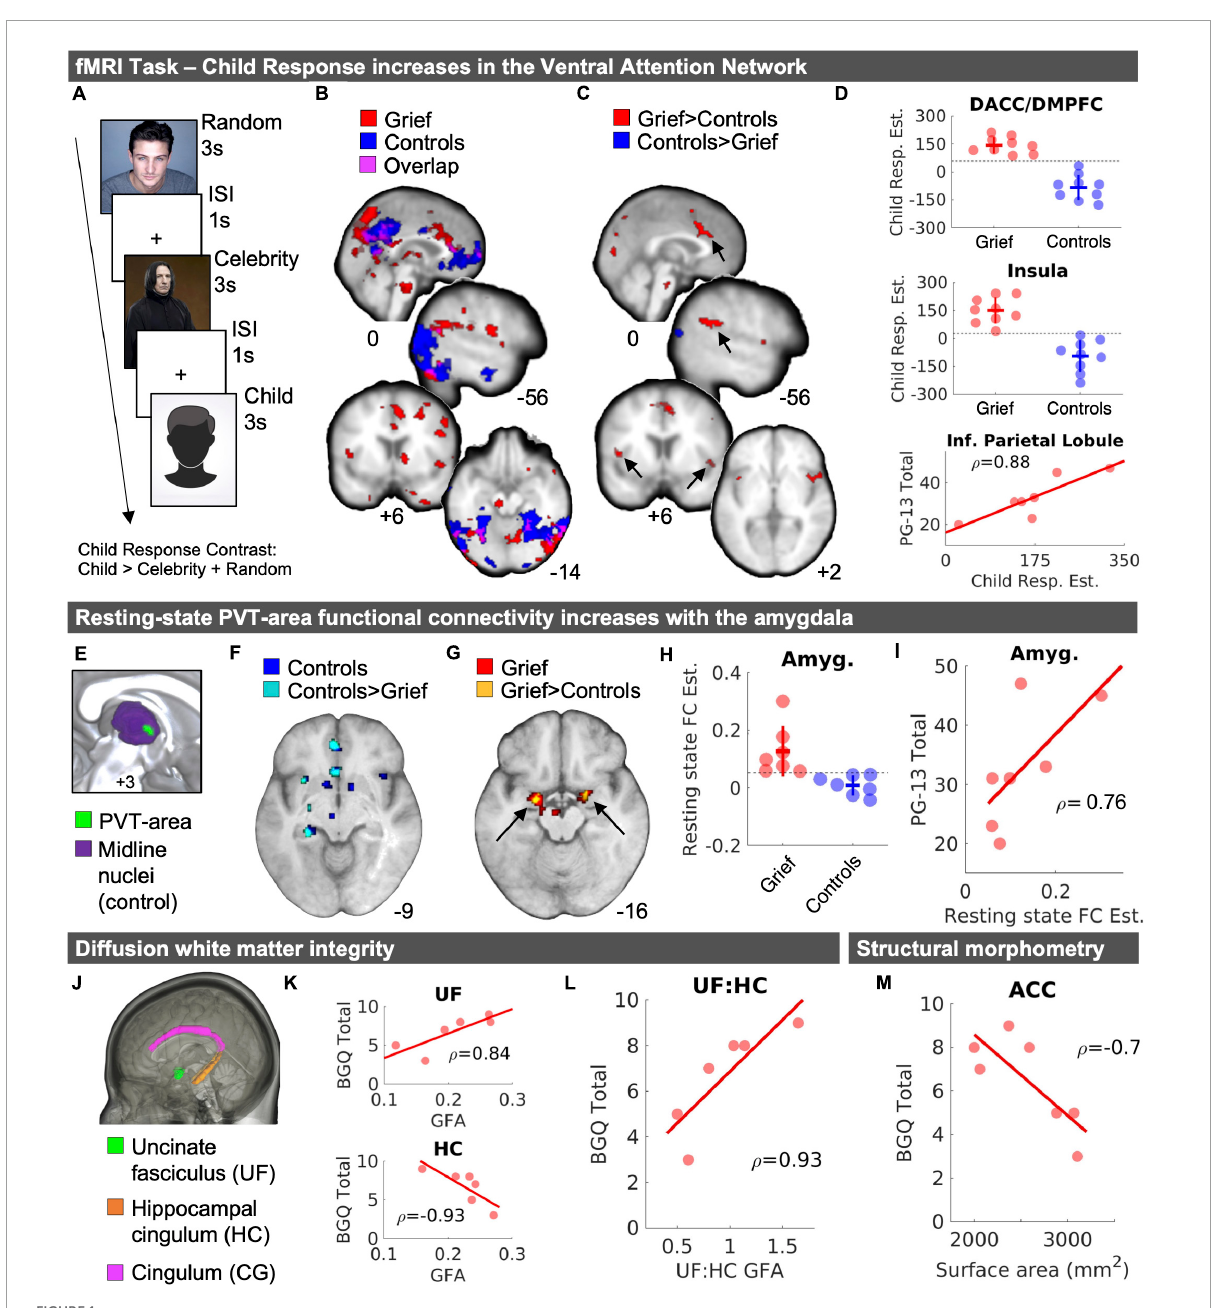
FIGURE1 MRI results. (A) Task structure. (B) Child fMRI Response (Child > Celebrity + Random) for Grief (red) and Control (blue) mothers and the spatial overlap of voxels shared between groups (violet). (C) Independent samples t- test results demarcate greater Child fMRI Responses in Grief compared to Controls (red) and Controls compared to Grief (blue). Arrows point to regions with corresponding plots in panel (D) . (D) Individual data points of Child fMRI Response magnitude in the dACC/DMPFC (top) and insula (middle) shown with standard deviation crossbars and dotted line illustrates numerical split between groups. The bottom panel of part (D) depicts a correlation between Child fMRI Response magnitude and subjective grief on the PG-13 in the inferior parietal lobule. (E) Midline view of PVT-area resting state functional connectivity analysis seed regions. (F) Resting-state fMRI results of PVT-area functional connectivity in controls (blue) and voxels that showed greater connectivity in controls compared to Grief mothers (cyan). (G) Resting-state fMRI results of PVT-area functional connectivity in Grief mothers (red) and voxels in the amygdala that showed greater connectivity in Grief mothers compared to controls (yellow). (H) Individual datapoints of PVT-area functional connectivity by group. The horizontal line highlights the complete numerical split between the groups. (I) Follow-up correlation analysis of PVT-area functional connectivity and PG-13 subjective grief scores. (J) Rendering of areas of interest in the DTI analysis. (K) Correlation plots between BGQ Total and UF (top) and HC (bottom). (L) Correlation plot shown for BGQ Total and UF: HC GFA ratio. Spearman’s rho ( ρ ) values are displayed with correlations. (M) Correlation between ACC surface area and subjective grief scores on the BGQ Total. DACC, dorsal anterior cingulate cortex; DMPFC, dorsomedial prefrontal cortex; PVT, paraventricular nucleus of the thalamus; Amyg., amygdala; FC, functional connectivity; PG-13, prolonged grief questionnaire; ACC, anterior cingulate cortex; GFA, generalized fractional anisotropy; BGQ, brief grief